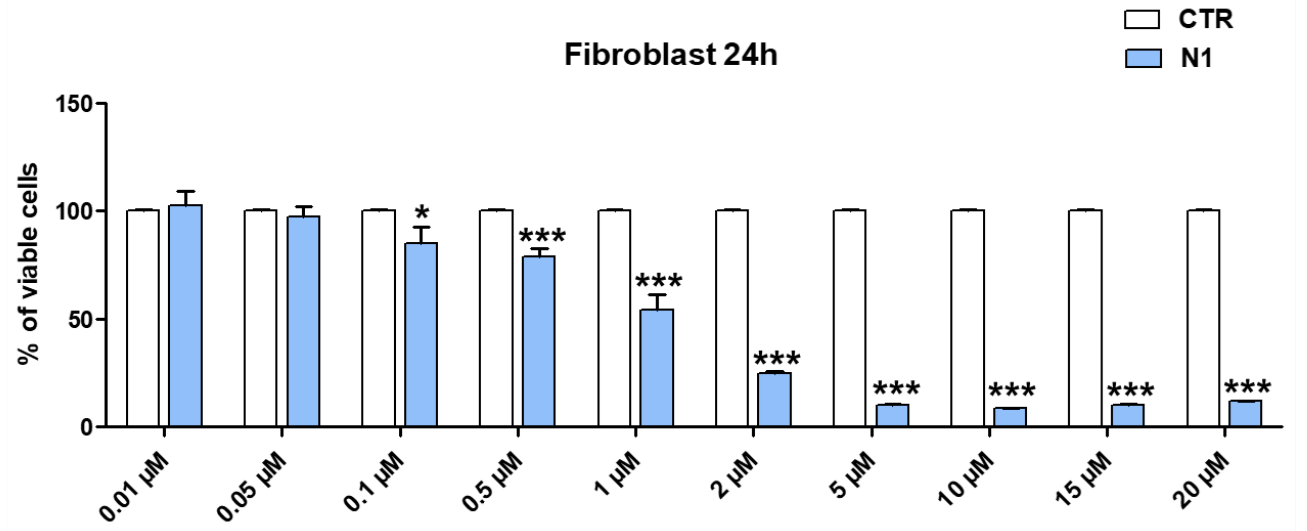
Figure 2. Results from dose-dependent cytotoxicity experiments carried out on MAIL-2 human cells at 24 h exposure to CP1 (N1 = CP1, CTR = control). * = p < 0.05, *** = p < 0.001.